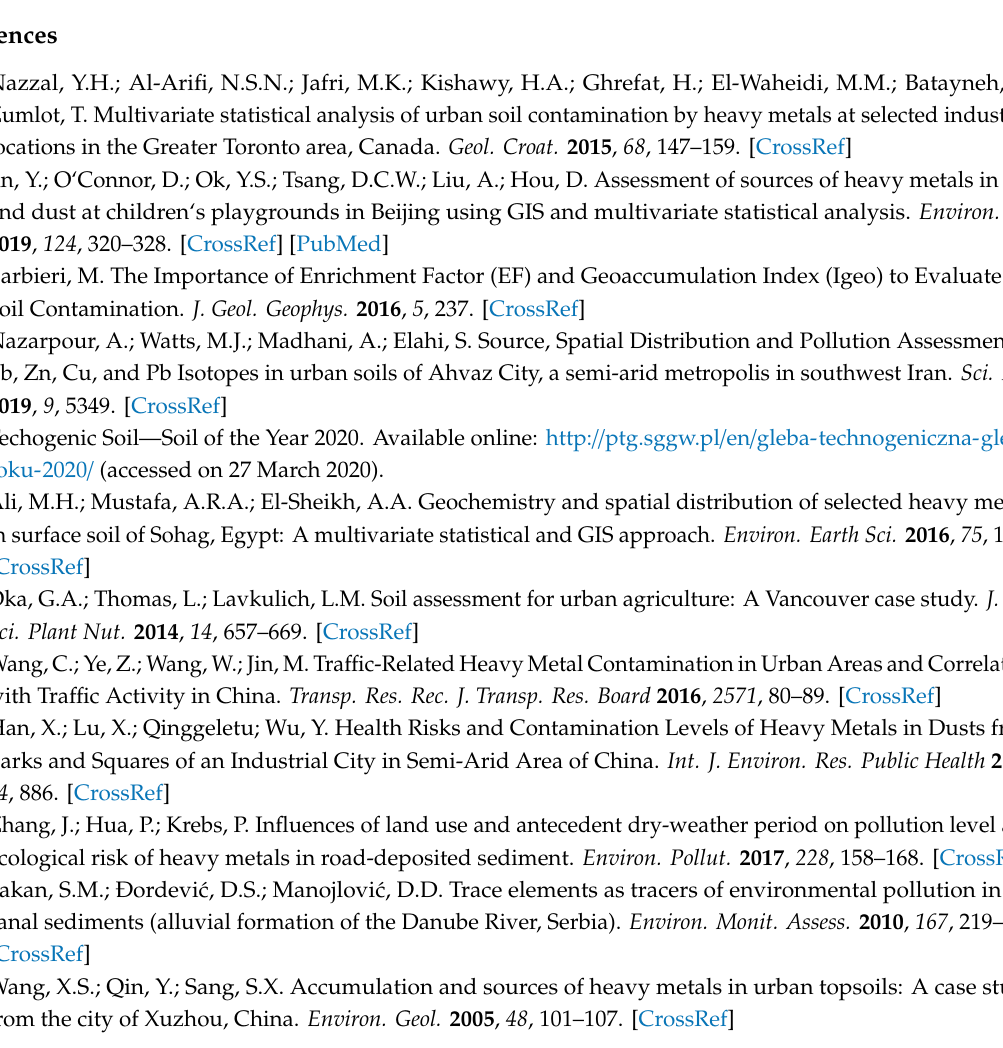
for sampling points, which are characterized by higher lead contents, Figure S2. Dendrogram for sampling sites, Figure S3. Dendrogram for sampling sites with scale of the linkage distance reducing to 50, Figure S4. Loading plot of the two main components PC1 and PC2 for PCA without outliers, Figure S5. Score plot of PC1 versus PC2 for PCA without outliers Table S1: Characteristic of sampling sites, Table S2. Metal mobile fraction (M) and total (T) contents in soils. Table S3. Contamination factors (CF) and pollution load index